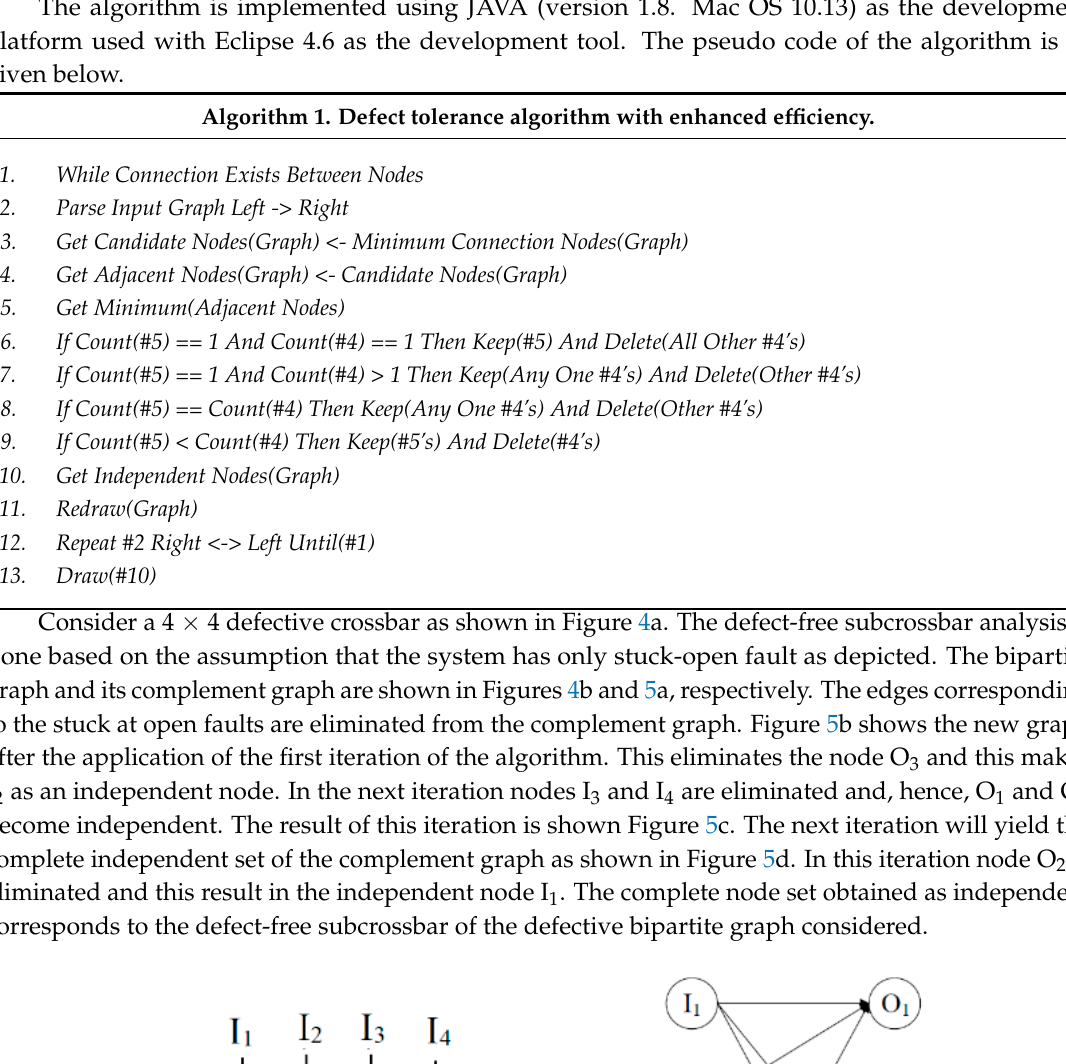
Algorithm 1. Defect tolerance algorithm with enhanced efficiency.